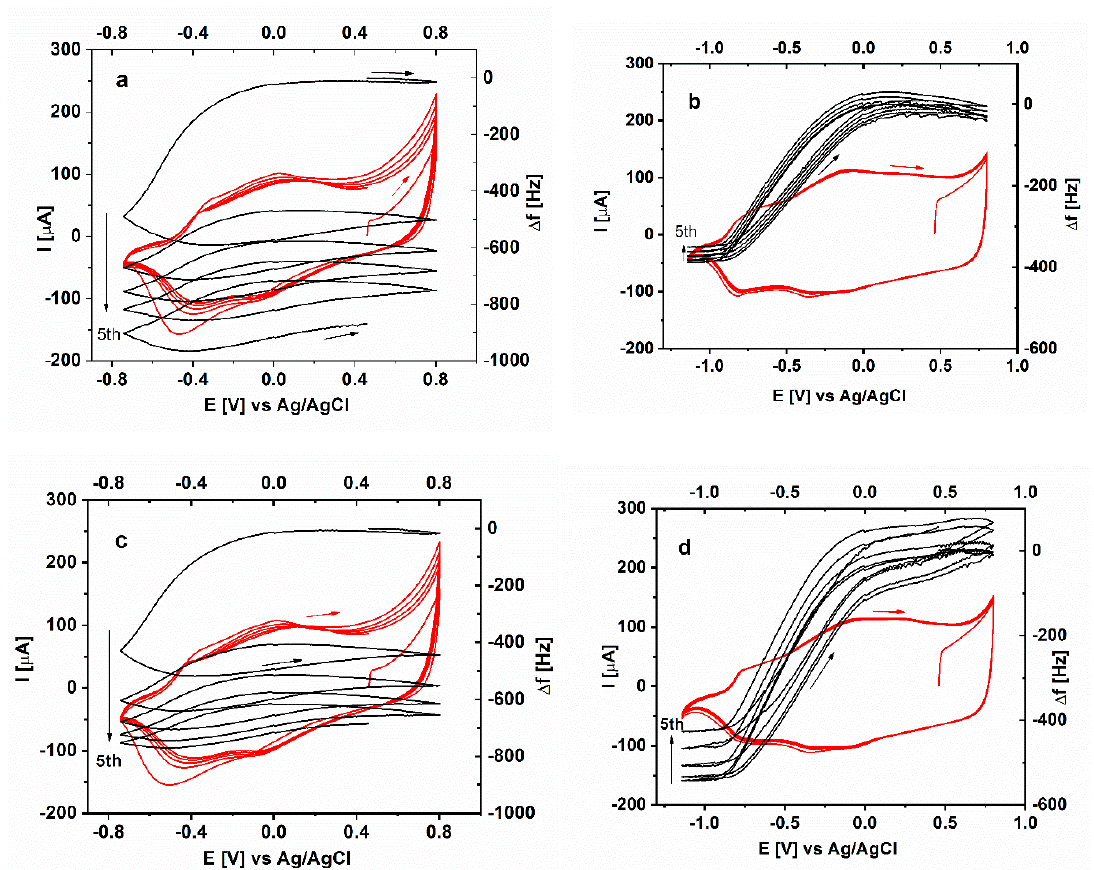
Figure 4. Simultaneous electrochemical (red) and microgravimetric (black) measurements in the course of five voltametric scans in aqueous solution of 0.1 M LiClO 4 for PEDOT films electrodeposited in the presence of: ( a ) i-PASA, ( b ) i-PASNa, ( c ) t-PASA and ( d )